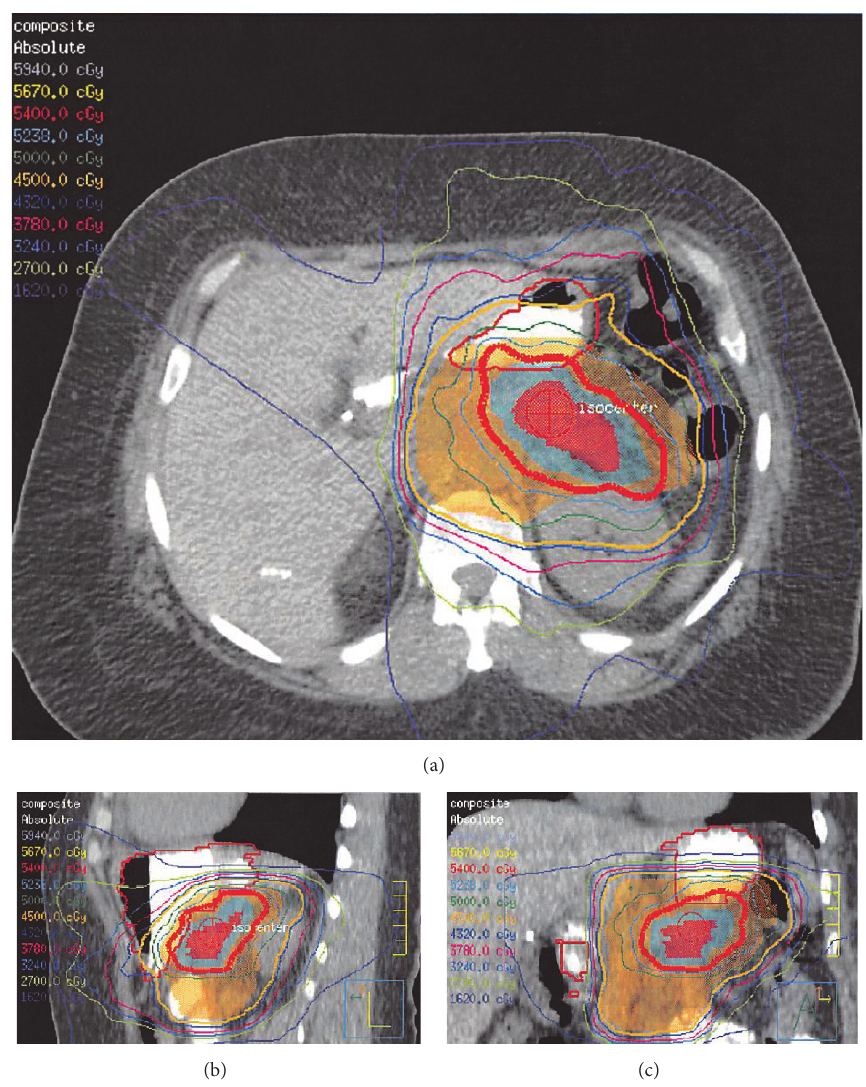
Figure 2: Axial, sagittal, and coronal isodose distribution of IMRT plan to 54Gy in 30